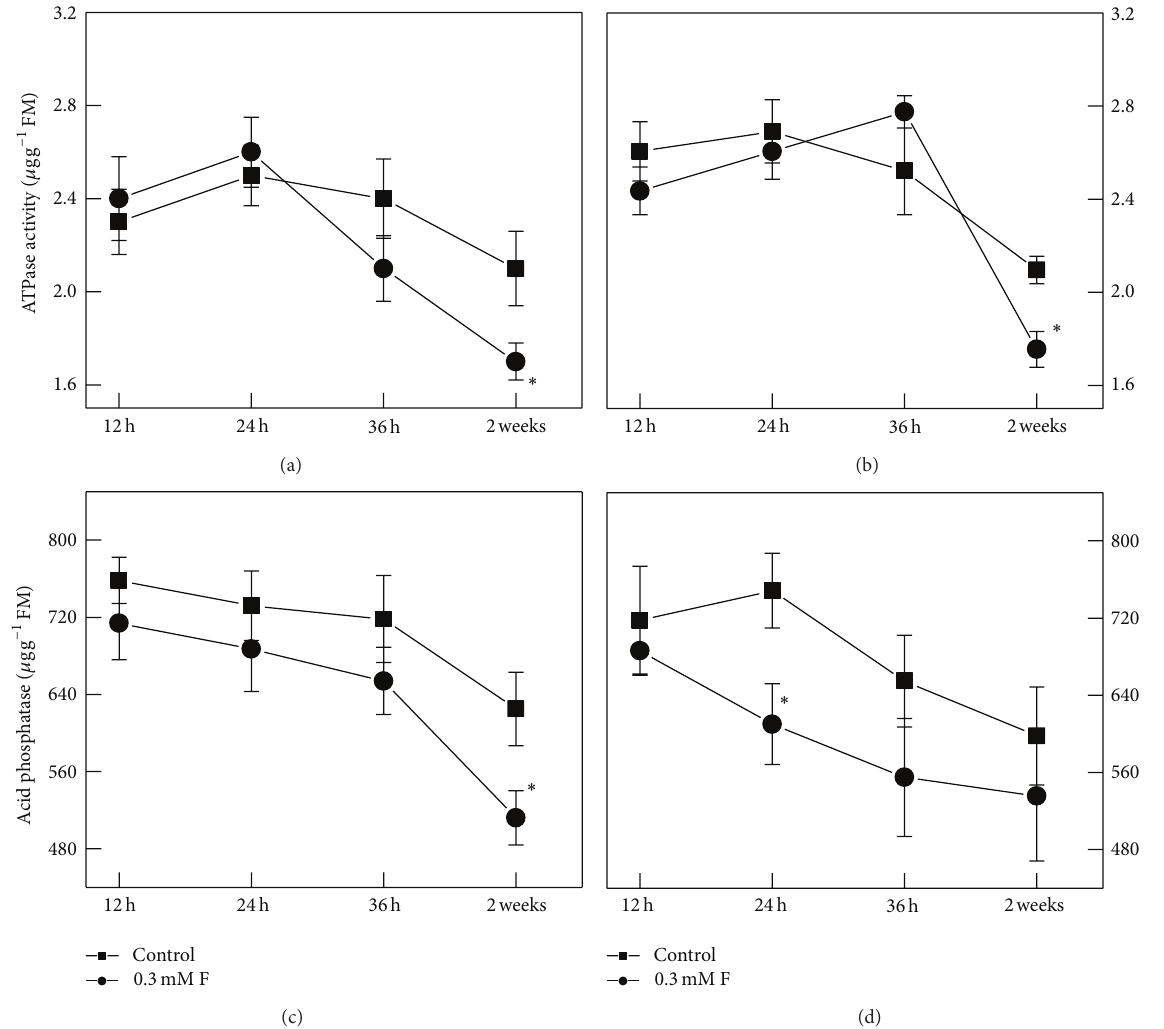
Figure 3: ATPase and acid phosphatase activities in roots of PY and FD seedlings after 12h, 24 h, 36 h, and 2-week exposure to 0.3mM fluoride (F). Data are expressed as means ± SD ( 𝑛 = 4 ). PY: “Pingyangtezao” tea cultivar; FD: “Fudingdabai” tea cultivar. (a) ATPase activity in PY; (b) ATPase activity in FD; (c) acid phosphatase activity in PY; (d) acid phosphatase activity in FD. ∗ indicates significant difference compared with the control here at 𝑃 < 0.05 according to Fisher’s 𝐹